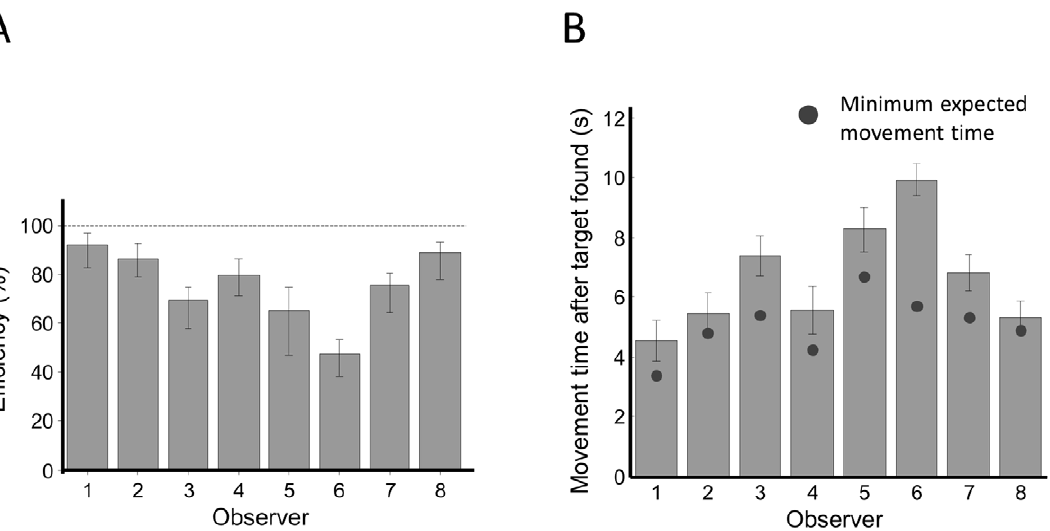
Figure 5. Search-Reach: Human observers’ performance compared to optimal. A. Efficiency . Efficiency was defined as the average gain of successful trials divided by the maximal expected gain. Most observers were far from optimal. The median efficiency across observers was 78%. B. Movement time after the target was found . Black dot denotes the expected movement time after the target was found if the observer used the optimal visual search and hand movement strategies. All the observers’ mean post-found movement time were larger than the minimum expected movement time. For 6 of the 8 observers, the difference was significant. In both A and B, each bar is for one observer. Error bar denotes the 95% confidence interval. doi:10.1371/journal.pcbi.1002718.g005 now varying speed from zero to the observer’s full speed while adding angular errors to the portion of the hand trajectory before the target was identified. We assumed that the observer might search the small cluster first (123456) or the large cluster first (654321) and simulated for these two orders separately.